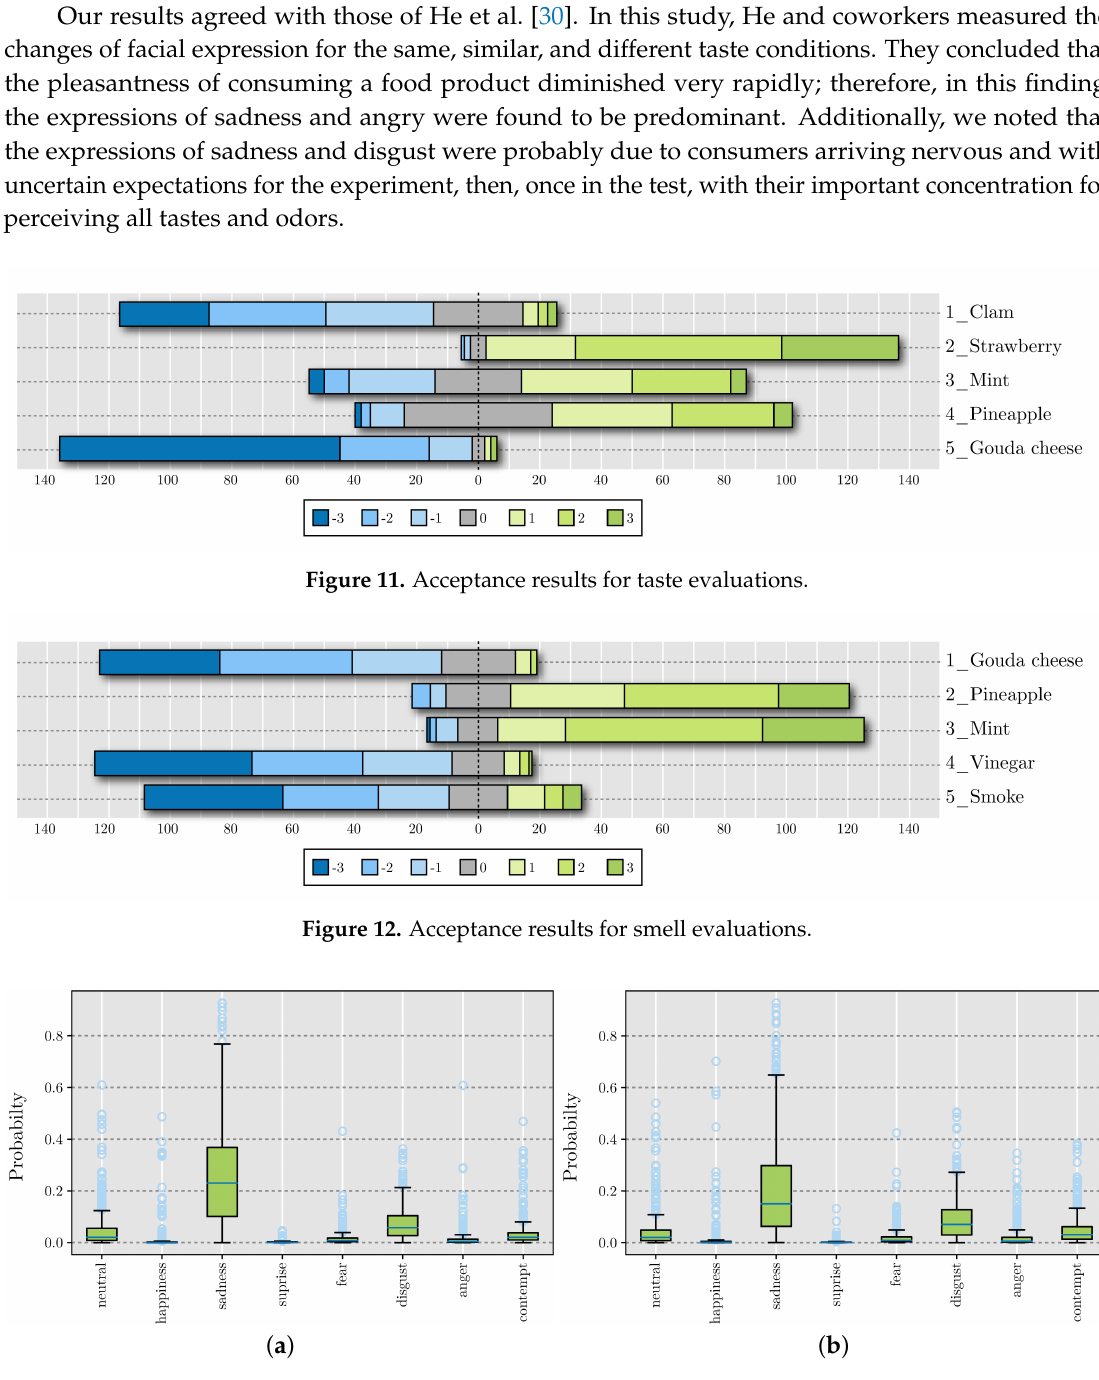
Figure 13. Recognized emotions: ( a ) taste and ( b ) smell experiments.